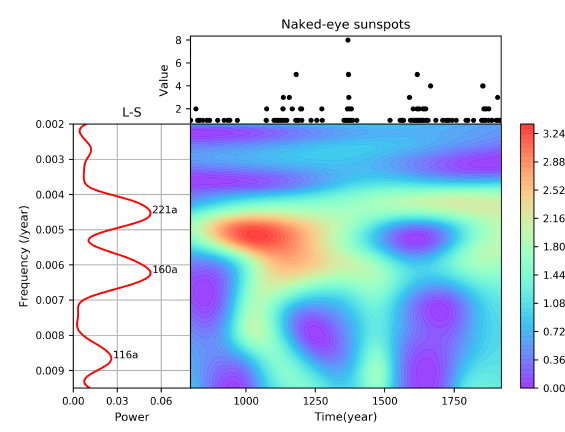
Figure 2. The weighted wavelet Z-transform (WWZ) results and the Lomb-Scargle periodogram of the naked-eye observations of sunspots from 800 AD to 1918